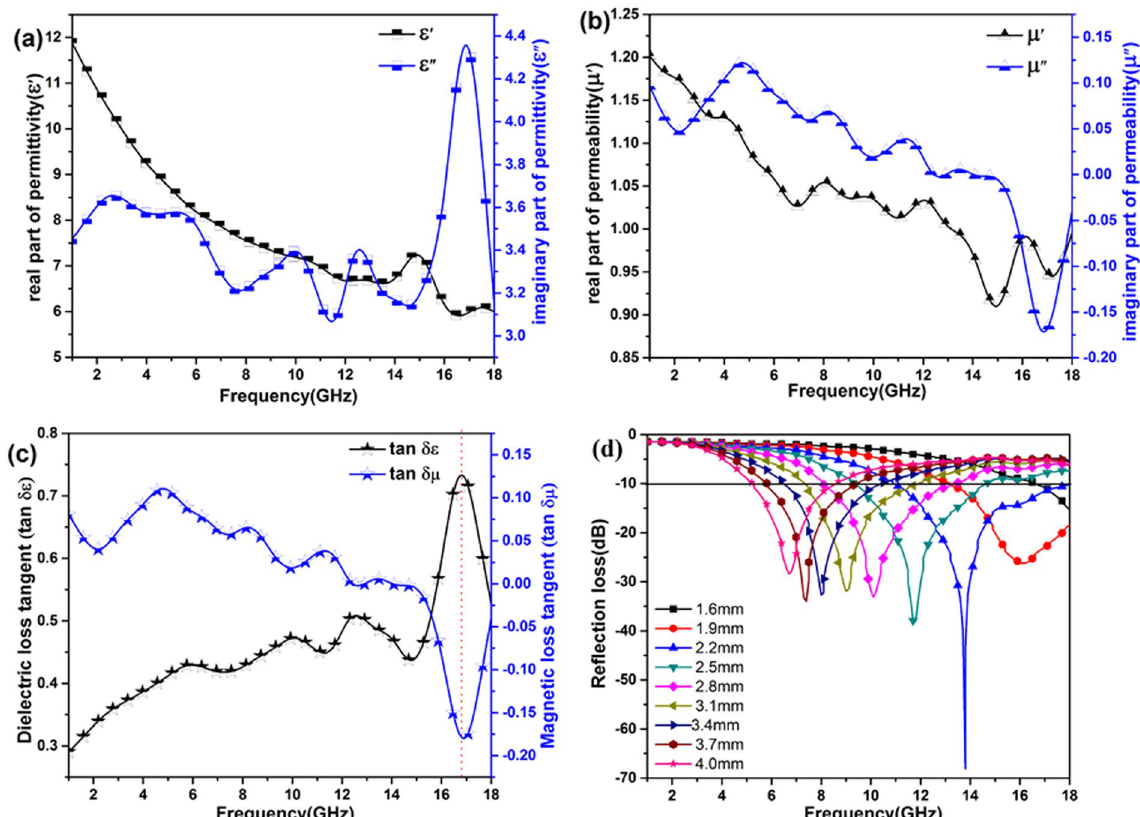
Figure 4. Relative complex permittivity ( a ), relative complex permeability ( b ), dielectric loss tangent (tan δ ε ) and magnetic loss tangent (tan δ μ ) ( c ) of paraffin composites filled with 33.3 wt% S 1.5 , and the calculated reflection loss of paraffin composites with different thicknesses ( d